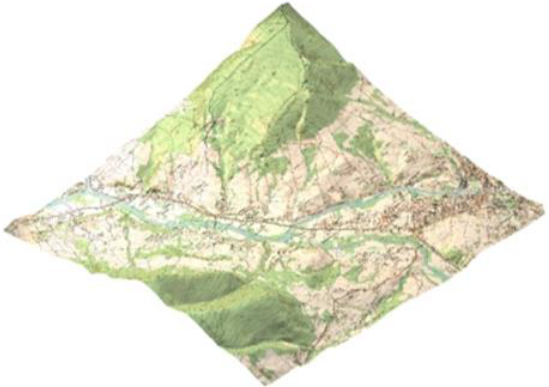
Figure 21. Textured DTM model — isometric view.